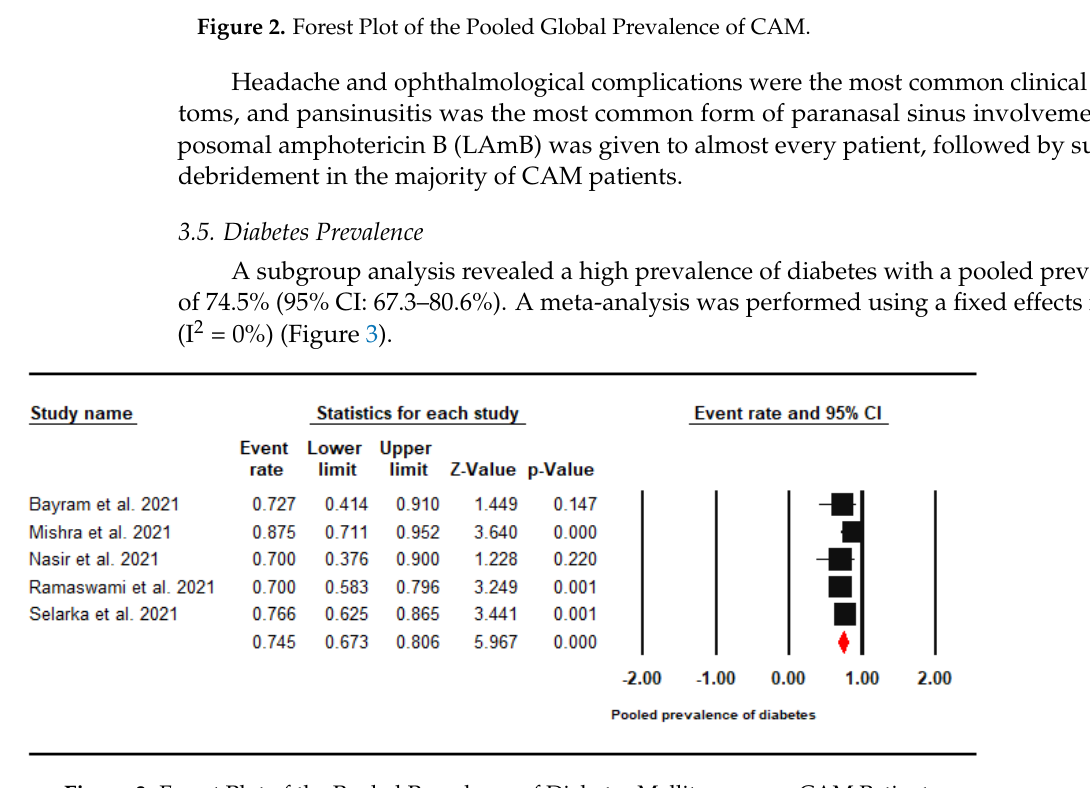
Figure 3. Forest Plot of the Pooled Prevalence of Diabetes Mellitus among CAM Patients.